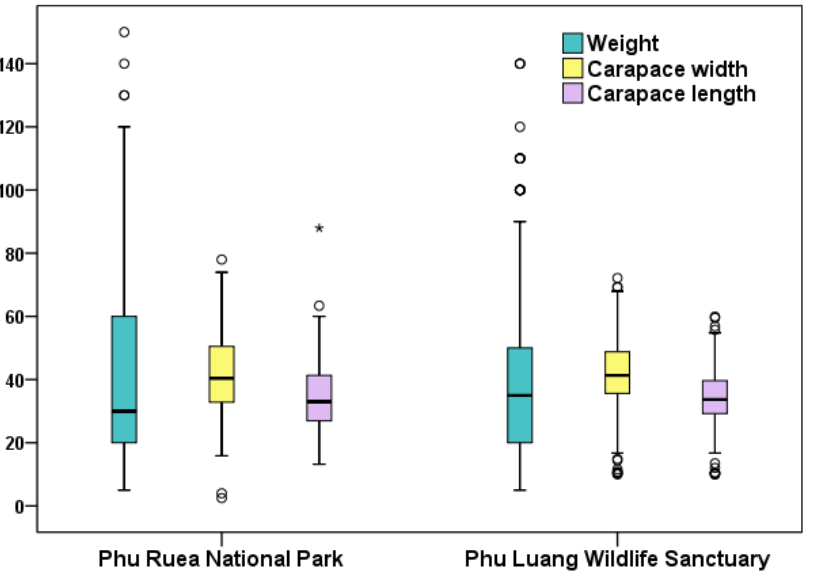
Figure 3. The body size of I. bhumibol in Phu Luang Wildlife Sanctuary (PL; n = 748) and Phu Ruea National Park (PR; n = 449). is outlier; * is extreme outlier. (cid:35) male and female crabs in the 12 sampling sites at the p = 0.01 level (Tables 4 and 5). The body weight of female crabs was significantly different between the two protected areas (W; t = 2.59, df = 529, p = 0.01), whereas the body weight and carapace width of male crabs were significantly different between the two protected areas (W; t = 2.1, df = 647, p = 0.03,